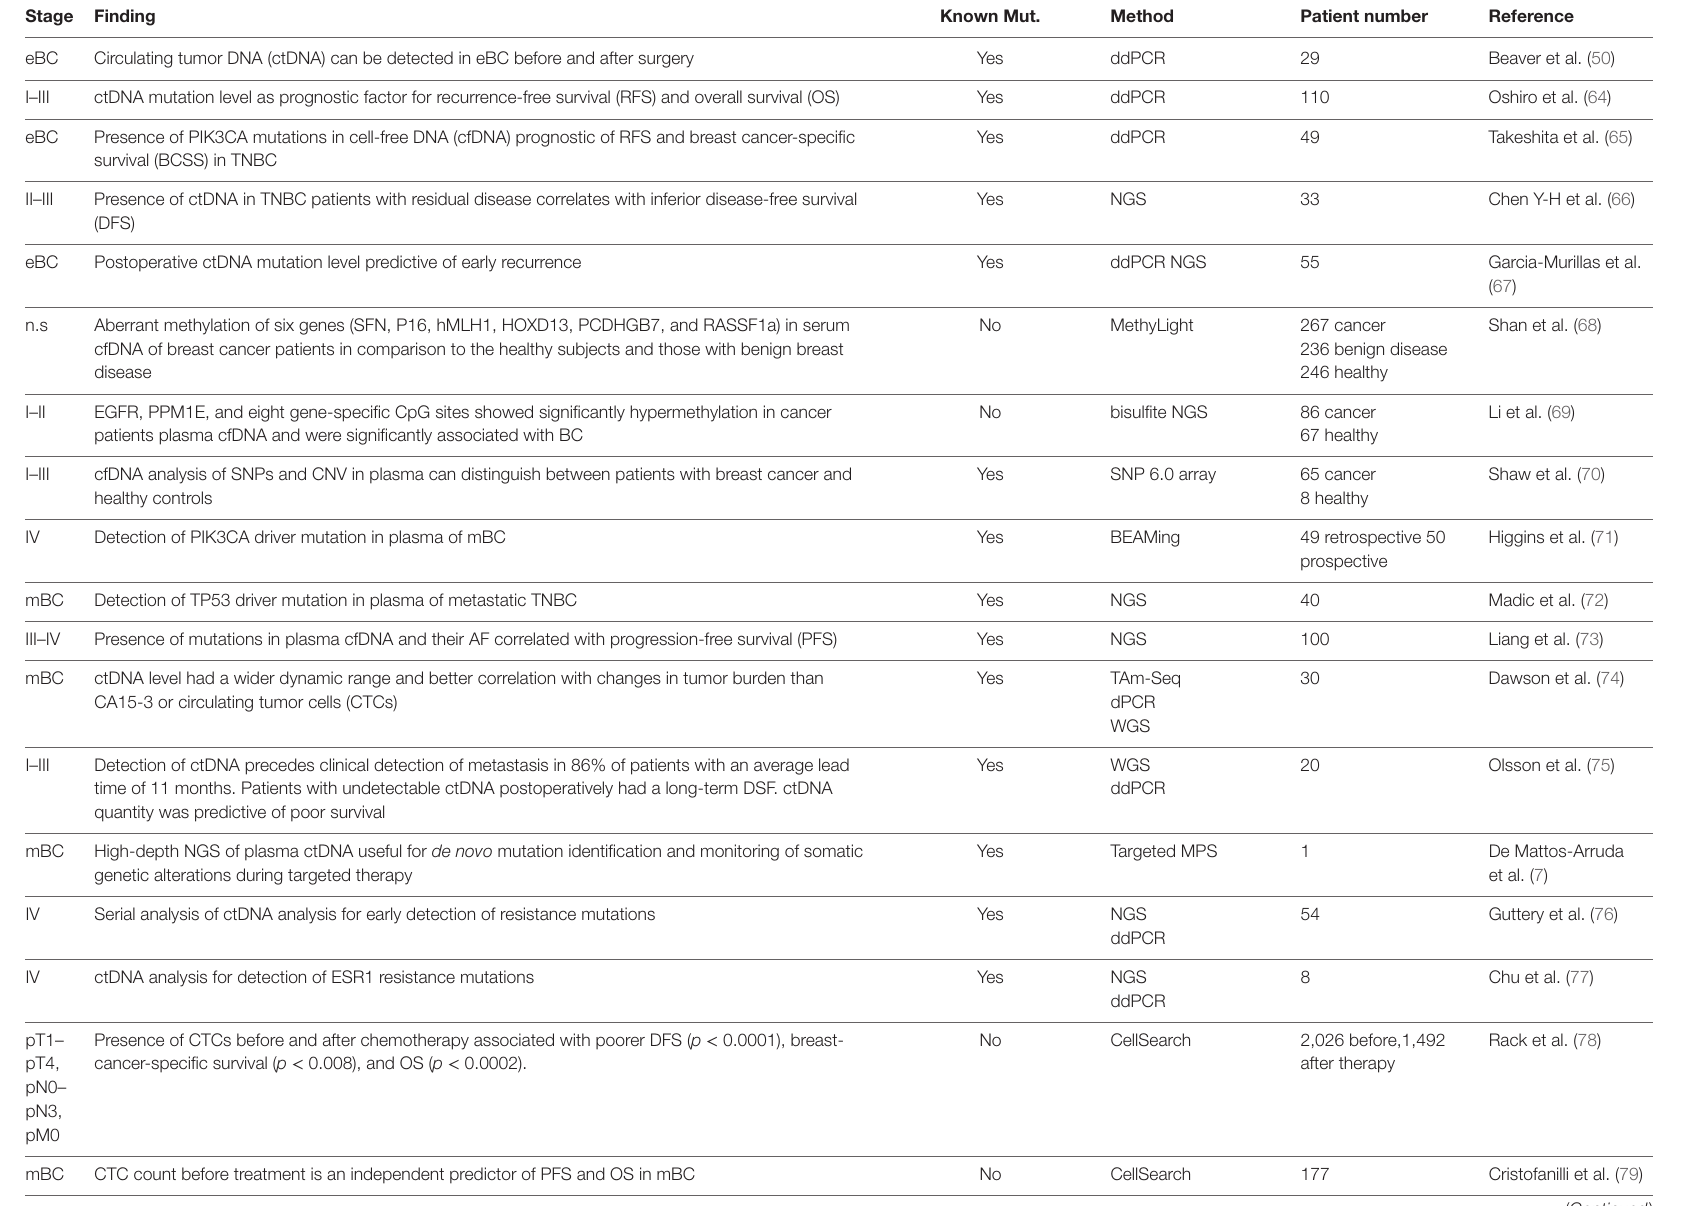
TABLe 1 | Breast cancer. Stage Finding Known Mut. Circulating tumor DNA (ctDNA) can be detected in eBC before and after surgery ctDNA mutation level as prognostic factor for recurrence-free survival (RFS) and overall survival (OS) Presence of PIK3CA mutations in cell-free DNA (cfDNA) prognostic of RFS and breast cancer-specific survival (BCSS) in